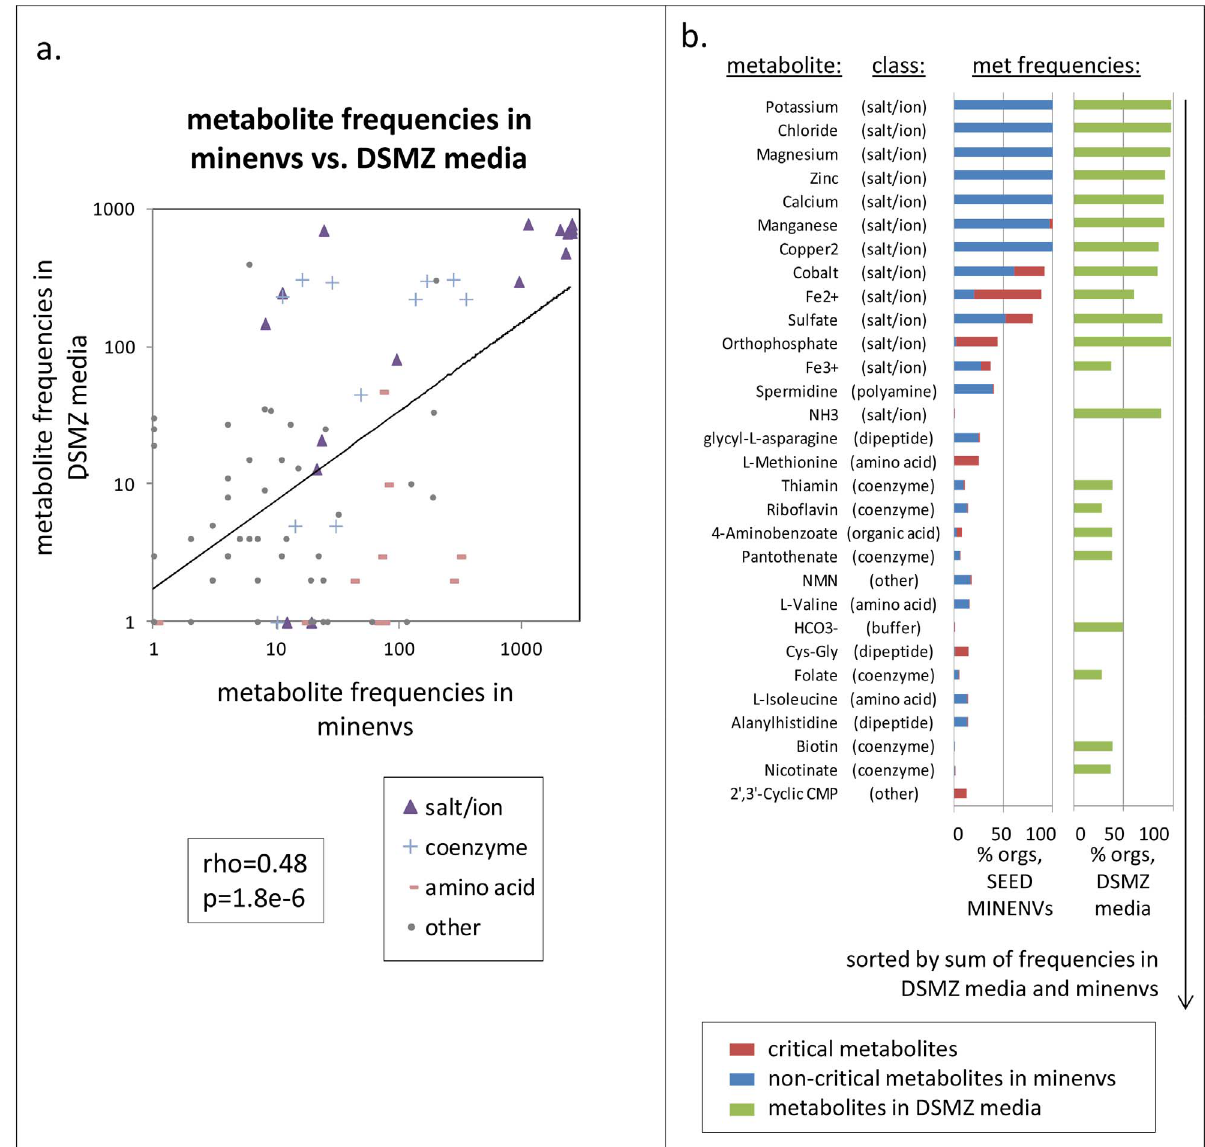
Figure 1. Metabolite prevalence in u-minenvs across organisms. (A) Frequencies of appearance are compared for all metabolites shared between the DSMZ known lab media and minenvs. Each metabolite is classed into one of 4 categories, as noted, and a trendline is shown. (B) The most common metabolites in minenvs and DSMZ media are listed, along with their compound class and their frequency in both spaces. Metabolites are sorted based on the sum of DSMZ media usage and minenv usage.